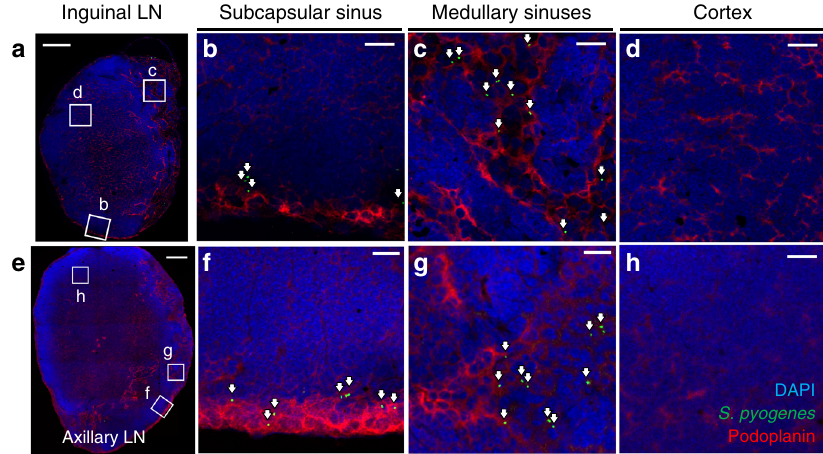
Fig. 3 S. pyogenes are con fi ned to sinuses within lymph nodes. a – h Immuno fl uorescence staining of local draining inguinal ( a – d ) and distant draining axillary ( e – h ) lymph node cryosections from FVB/n mice prepared 3 h after intramuscular injection into the hindlimb with 10 8 CFU of hypervirulent S. pyogenes (H1565); stained for S. pyogenes (green), podoplanin (red) and with DAPI (blue). White arrows highlight the location of S. pyogenes . Podoplanin staining highlights lymphatic endothelial cells in the subcapsular and medullary sinuses, as well as fi broblastic reticular cells in the cortex of the lymph node. Scale bars: 200 µ m ( a , e ); 20 µ m ( b – d , f – h ). Data are representative of fi ve independent experiments. See also Supplementary Fig. 4a, b, and Supplementary Movies 6 and the lymph node sinuses, we assessed the position of S. pyogenes infection, streptococci in ipsilateral axillary lymph nodes were within draining lymph nodes 3 h after infection with the predominantly seen in subcapsular sinuses, although an associa- hypervirulent strain H1565 using immuno fl uorescence micro- tion with high endothelial venules was evident at this time point scopy. In both ipsilateral inguinal lymph nodes (local draining) within non-draining lymph nodes, indicative of bloodstream (Fig. 3a – d and Supplementary Movie 6) and ipsilateral axillary spread (Supplementary Fig. 4a, b). lymph nodes (distant draining) (Fig. 3e – h and Supplementary Movie 7), bacteria accumulated in the subcapsular (Fig. 3b, f) and Bacterial virulence factors determine extent and consequences medullary sinuses (Fig. 3c, g), consistent with entry and exit of of lymphatic-dissemination . In principle, the small dimensions bacteria between sequential lymph nodes via the lymphatics. In contrast, very few streptococci were observed to have exited to the of bacteria alone might be suf fi cient to permit passive dis- lymph node parenchyma (Fig. 3d, h), or to have associated with semination via lymphatic channels. To determine whether the high endothelial venules, indicating a lack of direct bacterial entry process depended on the active involvement of bacterial virulence or exit through blood vessels in early infection. Even 24 h after mechanisms, we evaluated a panel of isogenic S. pyogenes strains.